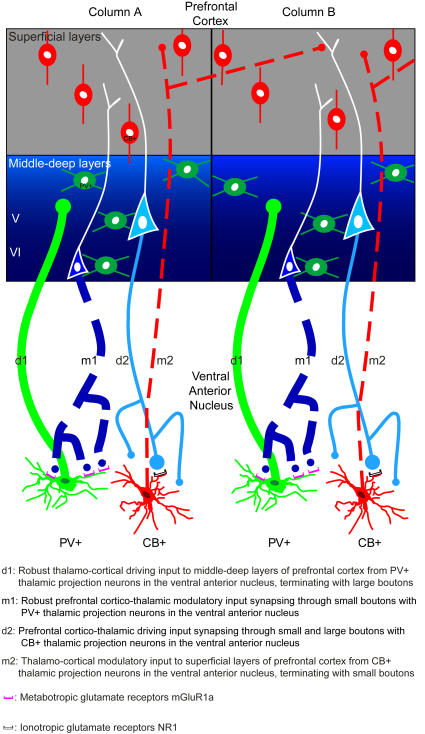
Schematic diagram summarizing the features of reciprocal driving and modulatory pathways linking the prefrontal cortex with the ventral anterior nucleus.The thickness of the lines, connecting thalamus and cortex, indicates the strength of the projection. The size of the dot indicates the size of the terminals. Solid lines (d1 and d2) represent driving projections, and dotted lines (m1 and m2) represent modulatory projections. Green represents PV+ labeling and red CB+ labeling. There were two parallel reciprocal circuits between the prefrontal cortex and ventral anterior nucleus. One originated mostly from PV+ thalamic projection neurons (green, bottom panels), and terminated focally as large boutons in the middle-deep layers (IIIb–VI, center blue panels) of the prefrontal cortex (d1). In turn, presumed layer VI neurons projected (m1) and terminated as numerous small boutons that formed synapses mainly with PV+ thalamic projection neurons (green, bottom panels), enriched with metabotropic receptors (mGluR1a, purple). The other circuit originated from CB+ thalamic neurons and sent widespread projections (m2) mainly to the superficial layers (I–IIIa) of the prefrontal cortex (grey), and terminated mostly as small terminals traversing the borders of neighboring regions and in association with the apical dendrites of neighboring layer V neurons. In turn, a prefrontal pathway (d2) established synapses through many small and fewer large boutons mainly on CB+ thalamic projection neurons (red) with ionotropic receptors (NR1, white). The PV+ thalamo-cortical pathway (d1) terminated mostly in the middle-deep layers, which were also rich with PV+ local inhibitory neurons (green spheres). In contrast, the CB+ thalamo-cortical pathway (m2) terminated in the superficial layers, which were rich in CB+ local inhibitory neurons (red spheres).